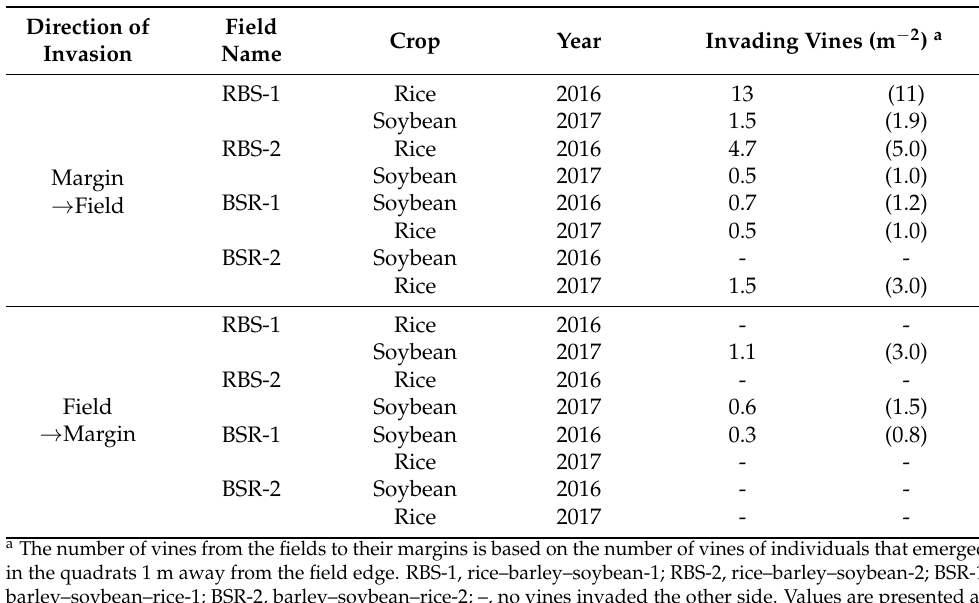
Table 1. Number of reciprocally invading vines of entireleaf morning glory between fields and their margins.